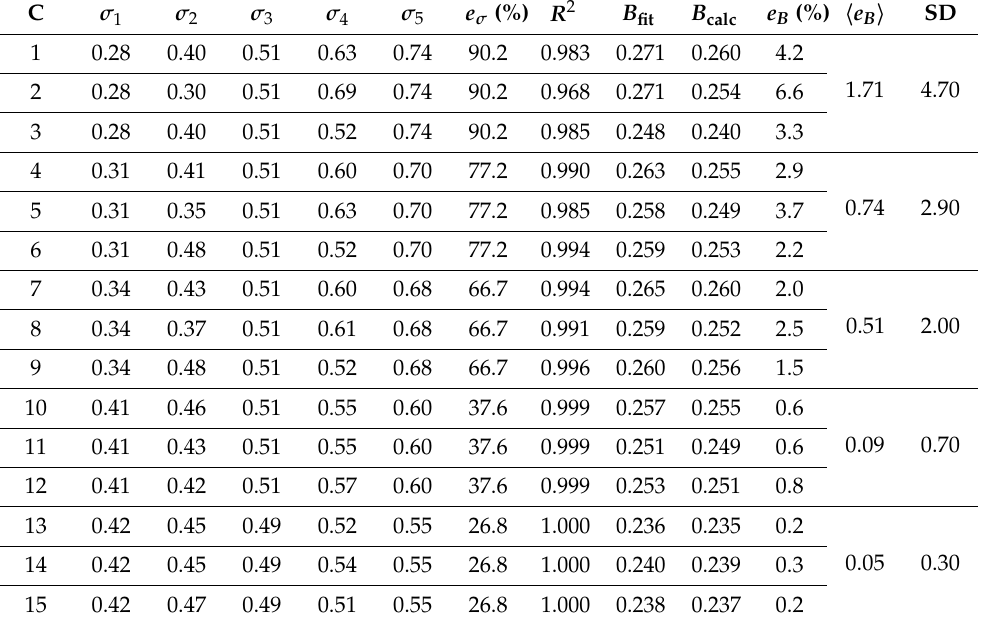
Table 2. Numerical experiments to estimate the accuracy in the evaluation of the parameter B ( k = 5). We have generated 10 6 Gaussian-distributed random numbers for each of the five Gaussian